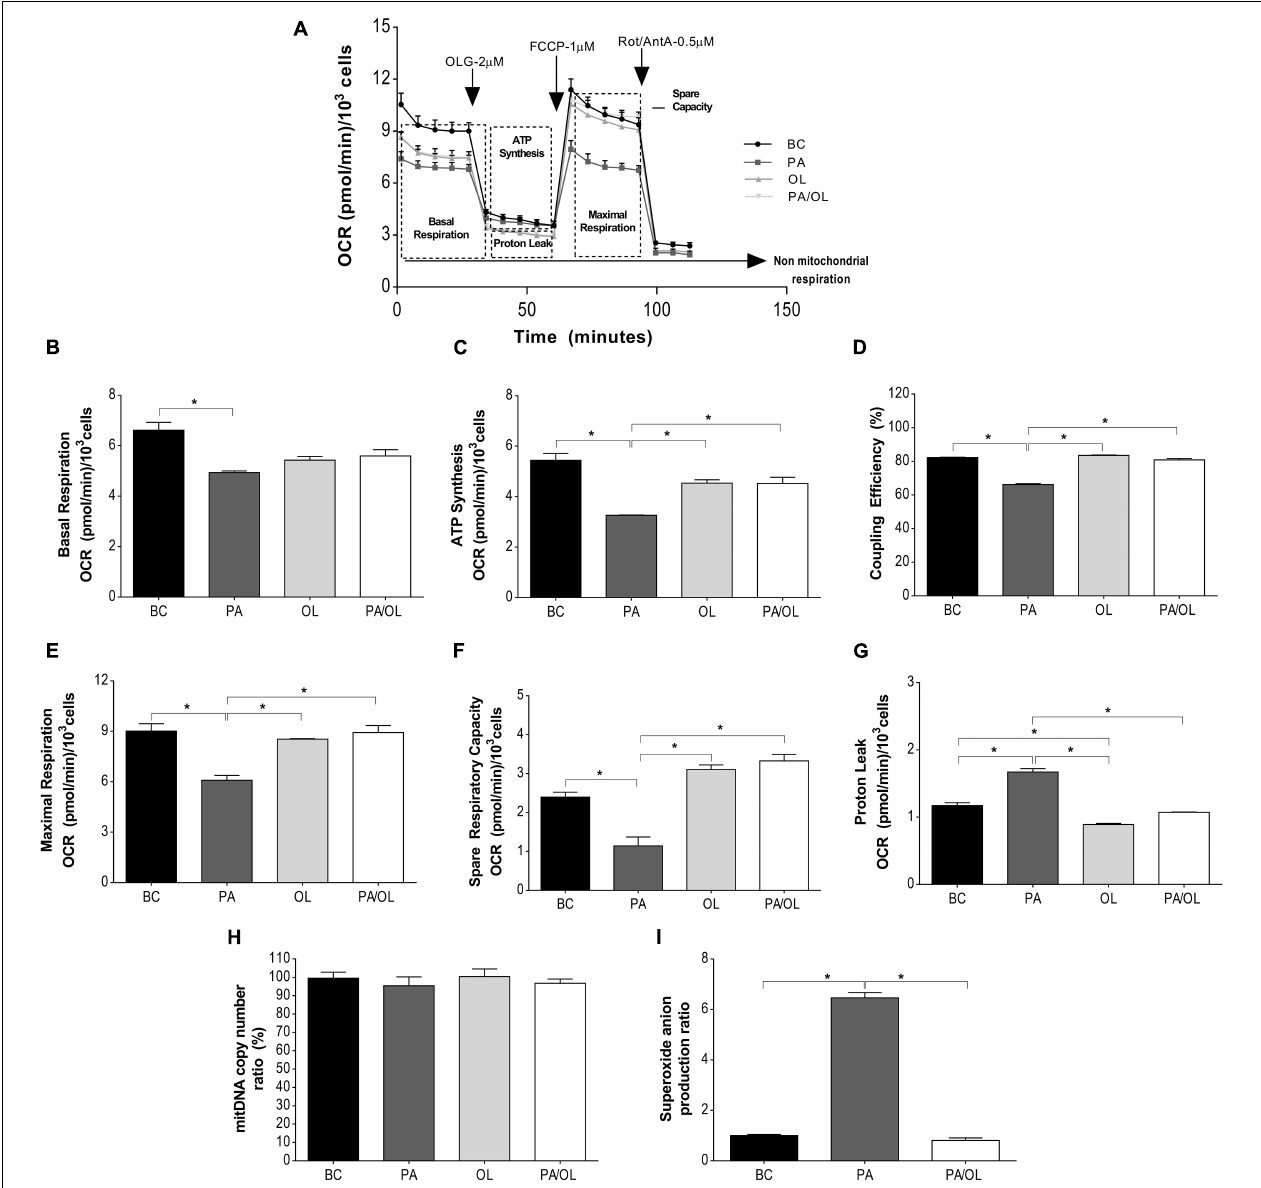
FIGURE 2 | Analysis of mitochondrial function by measurement of the oxygen consumption rate (OCR). (A) Representation of the OCR versus time for each of the fatty acid (FA) test solution (without FBS) incubations following the successive addition of each of the modulators of mitochondrial activity: OLG at 2 µ M; FCCP at 1 µ M and a mixture of Rot/AntA at 0.5 µ M. From these OCR values, the following parameters were calculated: (B) OCR due to basal respiration; (C) ATP synthesis; (D) coupling efficiency (%); (E) maximal respiration; (F) spare respiratory capacity; (G) proton leak; (H) percentage (%), relative to the basal condition (BC), of the number of copies of mitochondrial DNA; and (I) ratio in relation to BC of mitochondrial superoxide anion quantification expression. All data were obtained from three independent experiments, expressed as mean value ± deviation standard; * p < 0.05. BC = basal condition; PA = palmitic acid; OL = oleic acid; OLG = oligomycin; FCCP = carbonyl cyanide-p-trifluoromethoxyphenylhydrazone; ROT = rotenone; AntA = antimycin A. FBS = fetal bovine